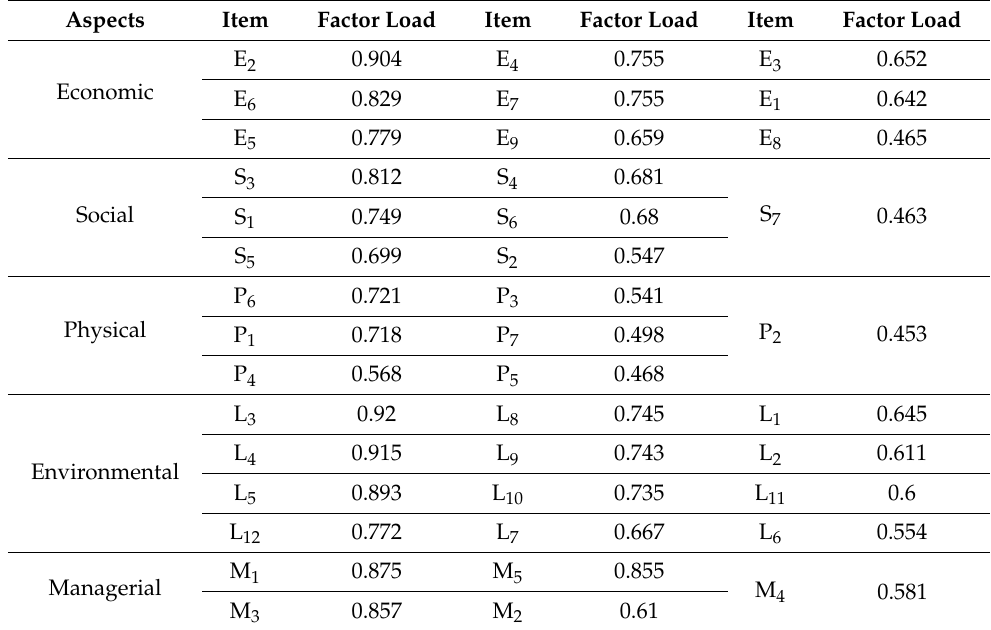
Table 5. Factor load results.